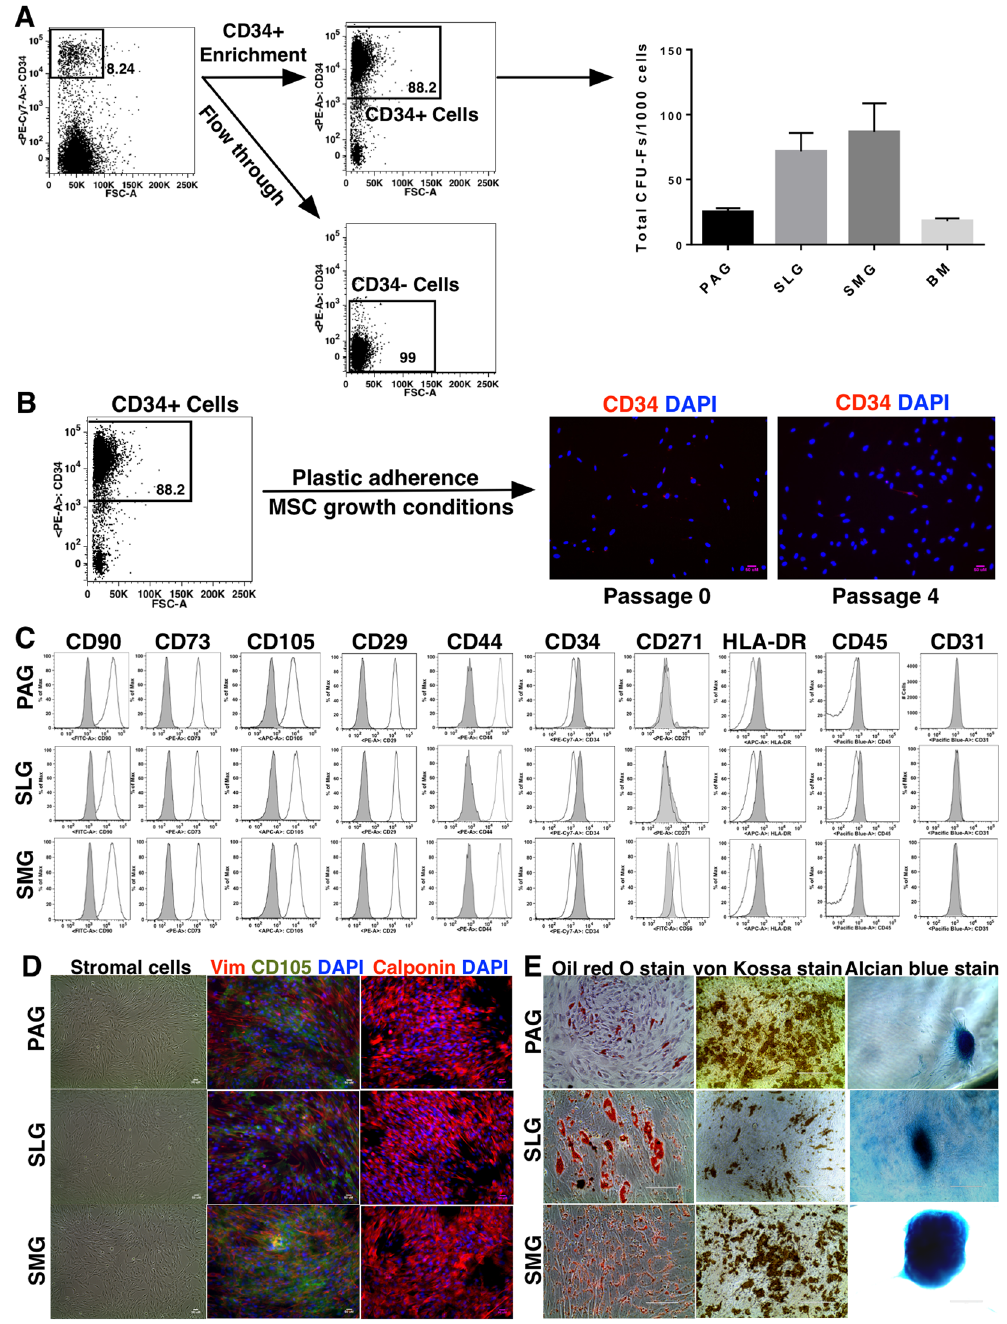
Figure 7. Phenotypic and functional characterization of CD34 + cell derived MSCs of fetal SGs ( A ) positive selection of CD34 + cells, and CFU-Fs formed per 1000 CD34 + cells ( B ) CD34 expression on cultured MSCs [Passages (P) 0 and 4]. All scale bars represent 50 µ M. ( C ) Phenotypic analyses of MSC specific cell surface markers on cultured MSCs (P3 to 12), isotype control (grey). ( D ) Bright field stromal cell images, and expressions of vimentin (green), CD105 (red) and calponin (red) on cultured MSCs. Nuclei was stained in DAPI (blue). All scale bars represent 50 µ M. ( E ) Multilineage differentiation into adipogenic (oil Red O staining), osteogenic (von Kossa staining) and chondrogenic (Alcian blue staining) lineages (P3 to 12). All scale bars represent 100 µ